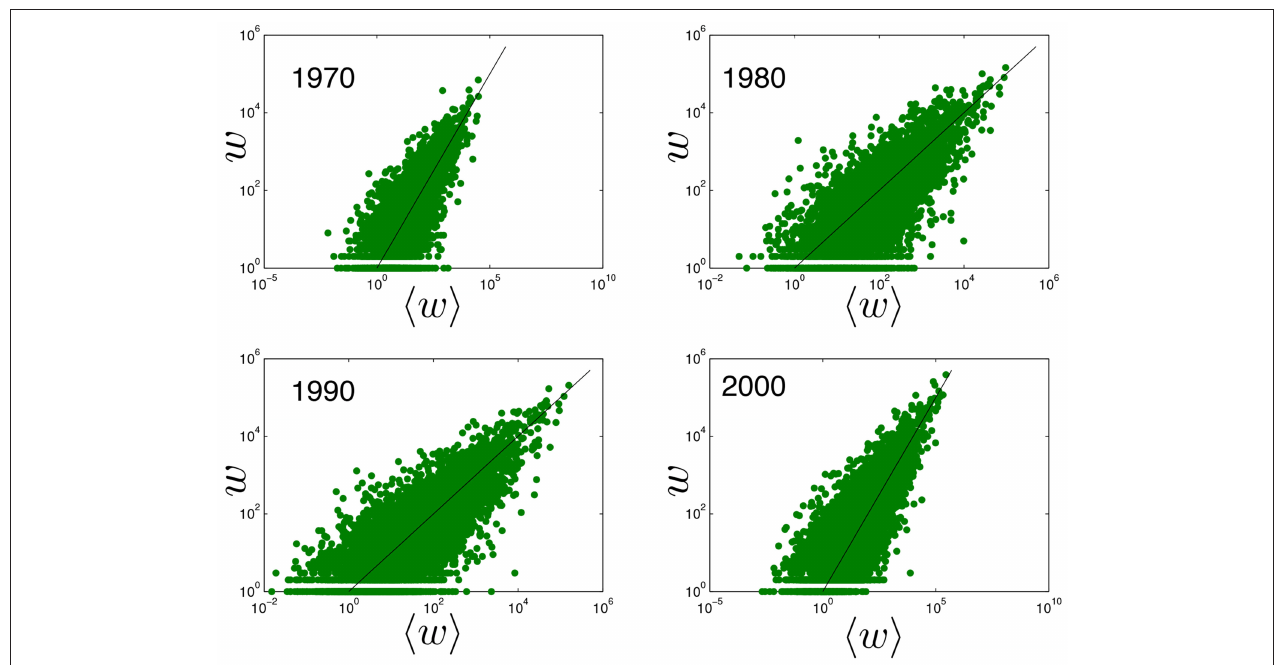
FIGURE 1 | Empirical non-zero trade flows vs. the corresponding expectation under the traditional Gravity Model. Log-log plot comparing the empirical volume ( y -axis) of all non-zero bilateral trade flows in the ITN with the corresponding expected volume ( x -axis) predicted by the Gravity Model defined in Equation (1), with parameters estimated as reported in Table 1 . Top left: year 1970, top right: year 1980, bottom left: year 1990, bottom right: year 2000. The black line is the identity line corresponding to the ideal, perfect match that would be achieved if the empirical weights were exactly equal to their expected values, i.e., in complete absence of randomness.